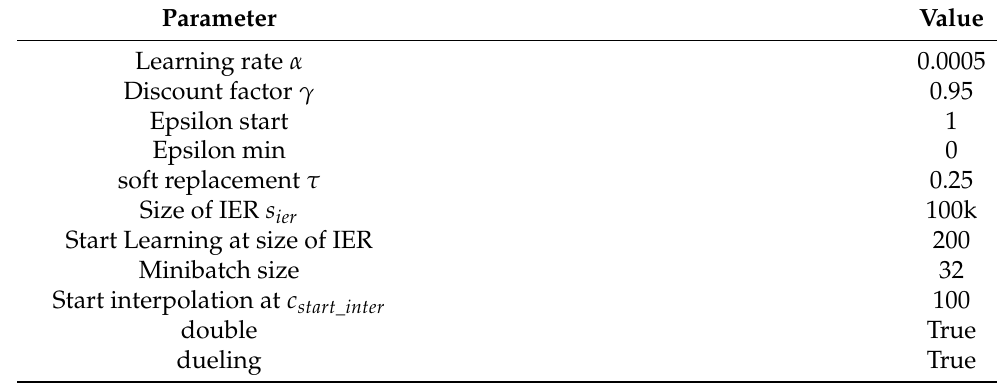
Table 2. An overview of hyperparameters applied for the FrozenLake8x8-v0